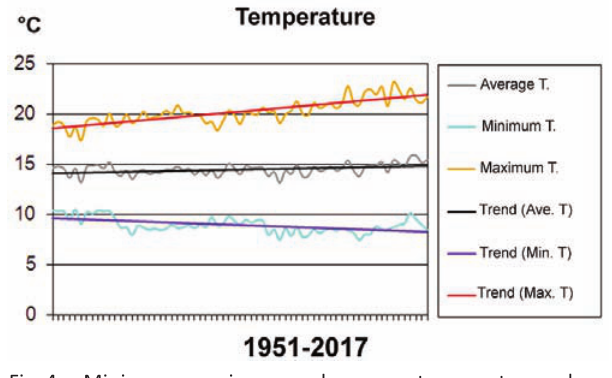
Fig. 4 - Minimum, maximum and average temperature values and